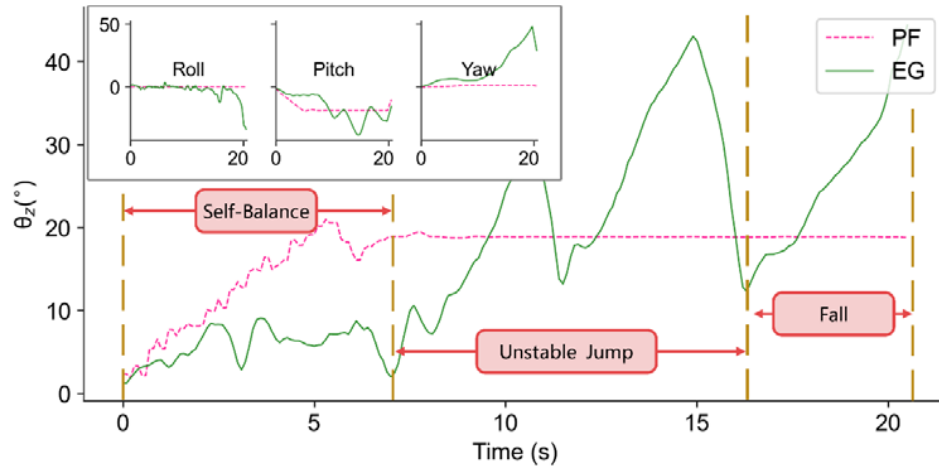
Figure 11. Three stages in the balance process when the platform tilts at the velocity of 5 ◦